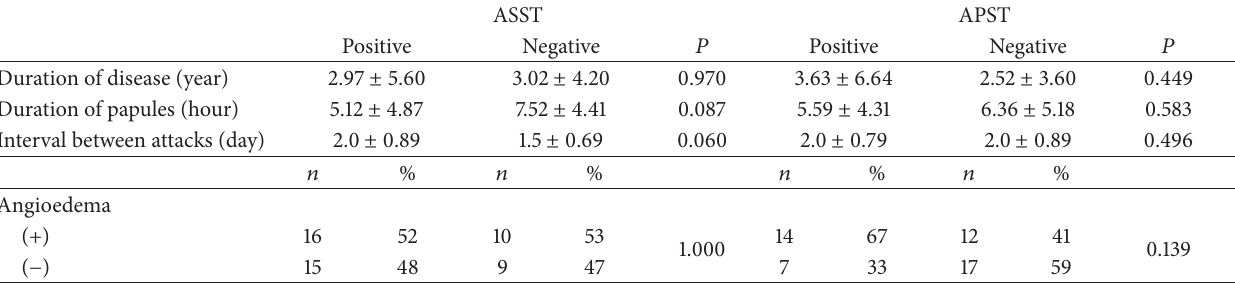
Table 4: The clinical characteristics of the patients according to ASST and APST responses. ASST APST 𝑃